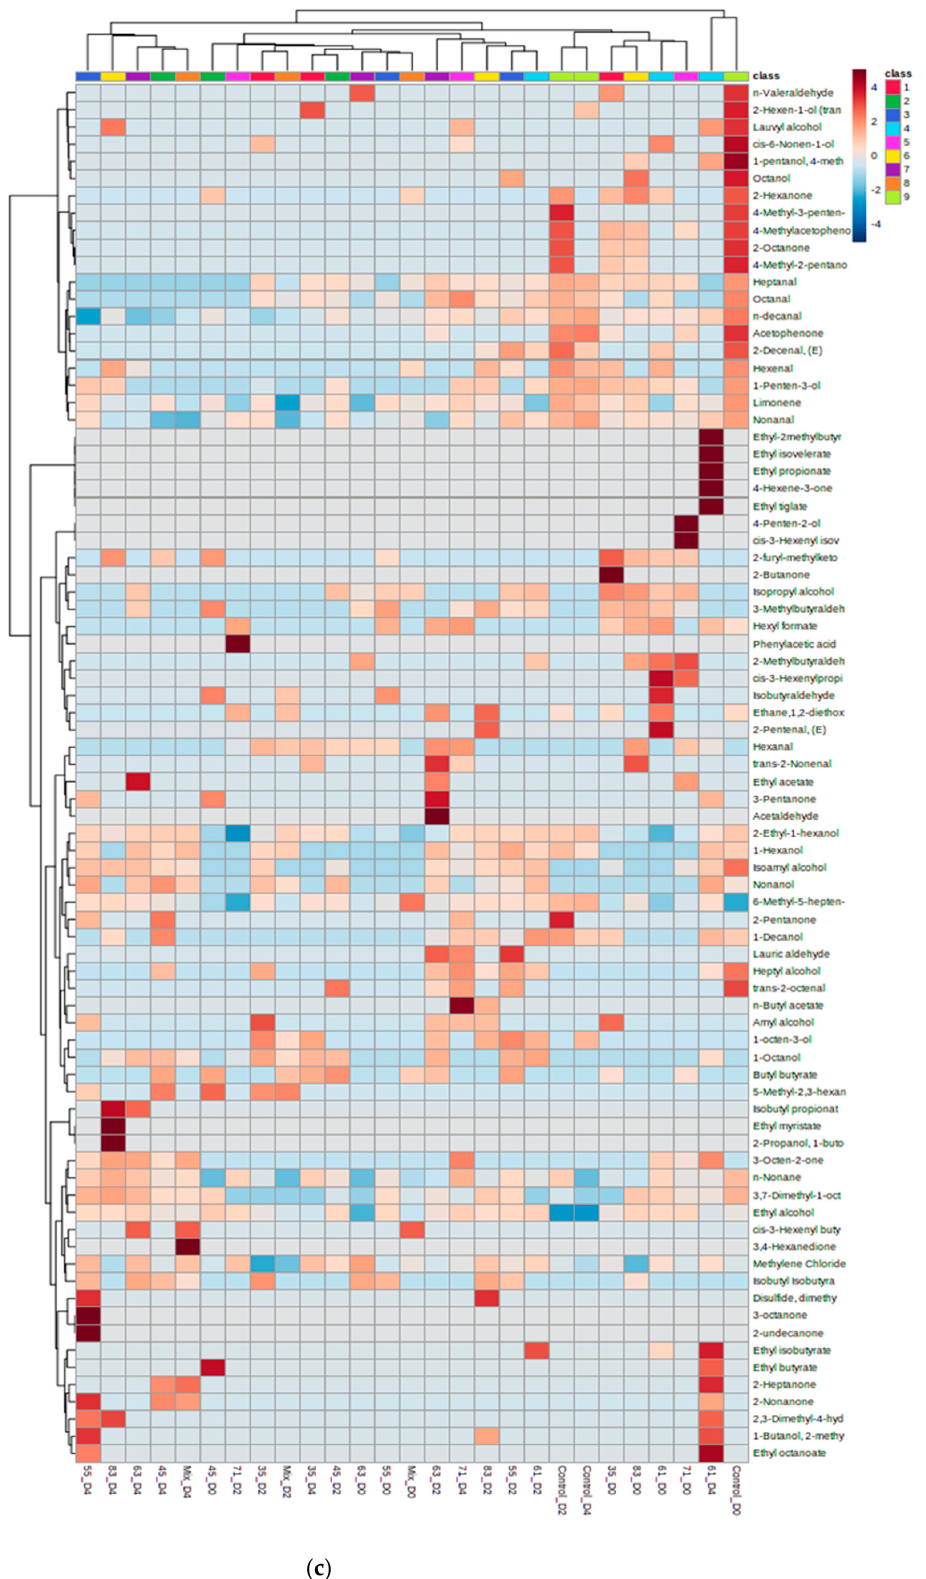
Figure 1. Hierarchical cluster analysis on heatmap plot between strains and VOC profile, during storage of inoculated fish juice agar model substrates at 0 °C ( a ), 4 °C ( b ) and 8 °C ( c ).